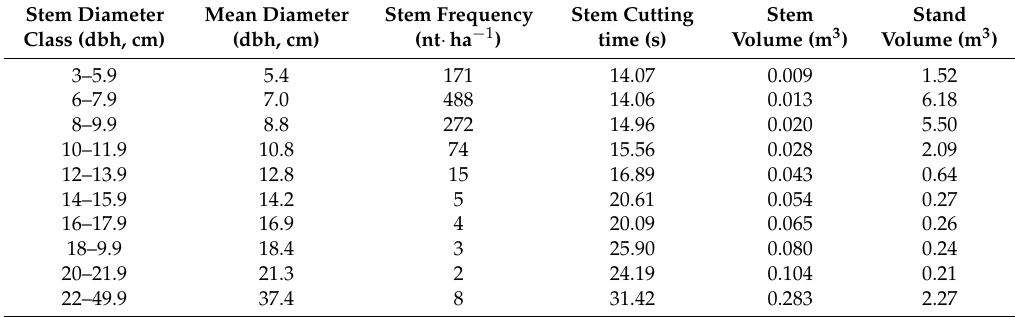
Table 1. Stand parameters for each diameter class in time-study report of the multiple-tree harvester. dbh, diameter at breast height; nt, number of trees; ha, hectare; s, second; m 3 , cubic meter (solid volume, scaled outside the bark).